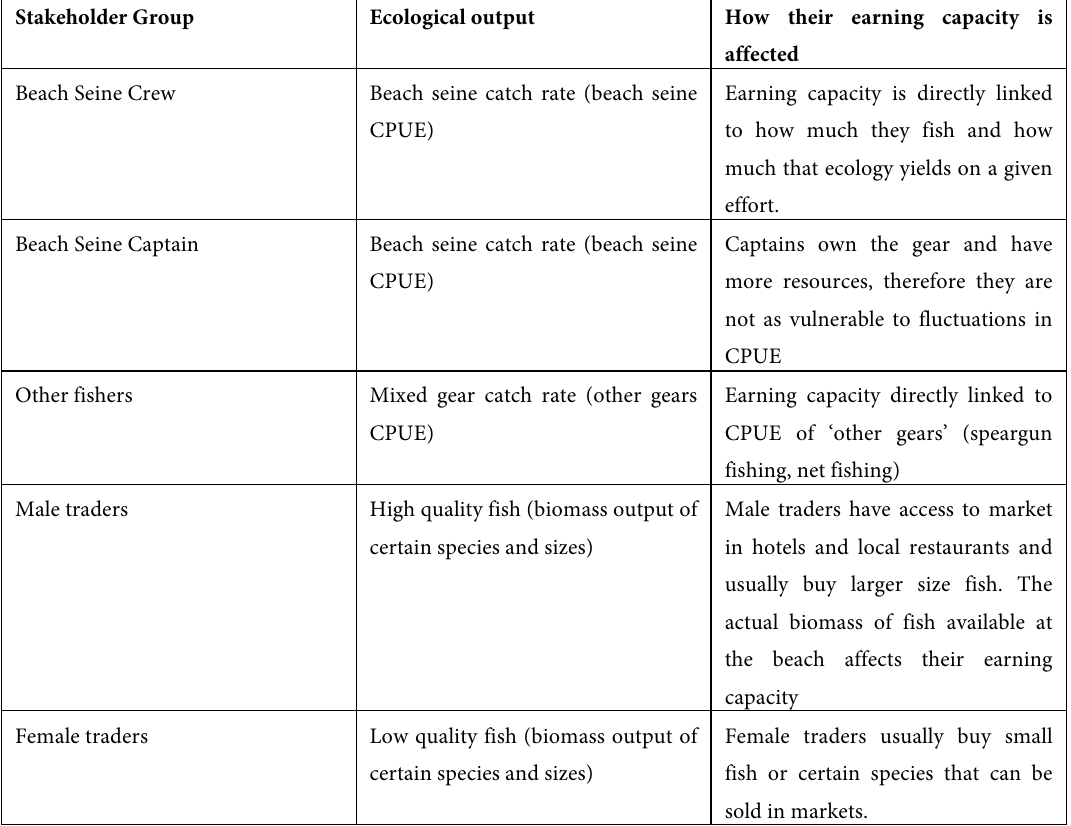
Table S2. Linkages between ecological outputs and primary stakeholders ‘earning capacity’. Stakeholder Group Ecological output How their earning capacity is